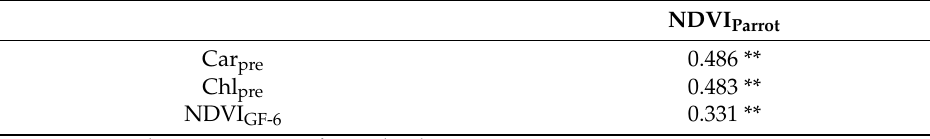
Table 6. Correlation statistics of 172